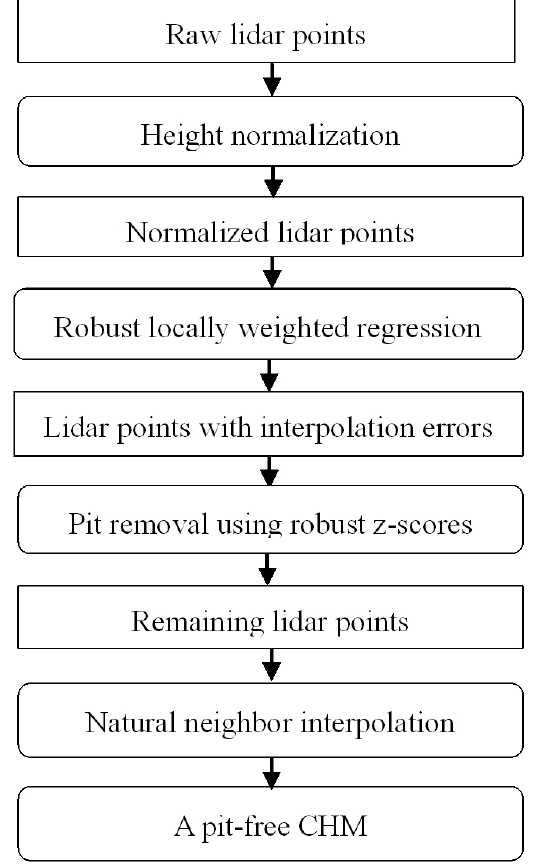
Figure 1. Flowchart of the proposed algorithm for pit-free canopy height model (CHM) construction.